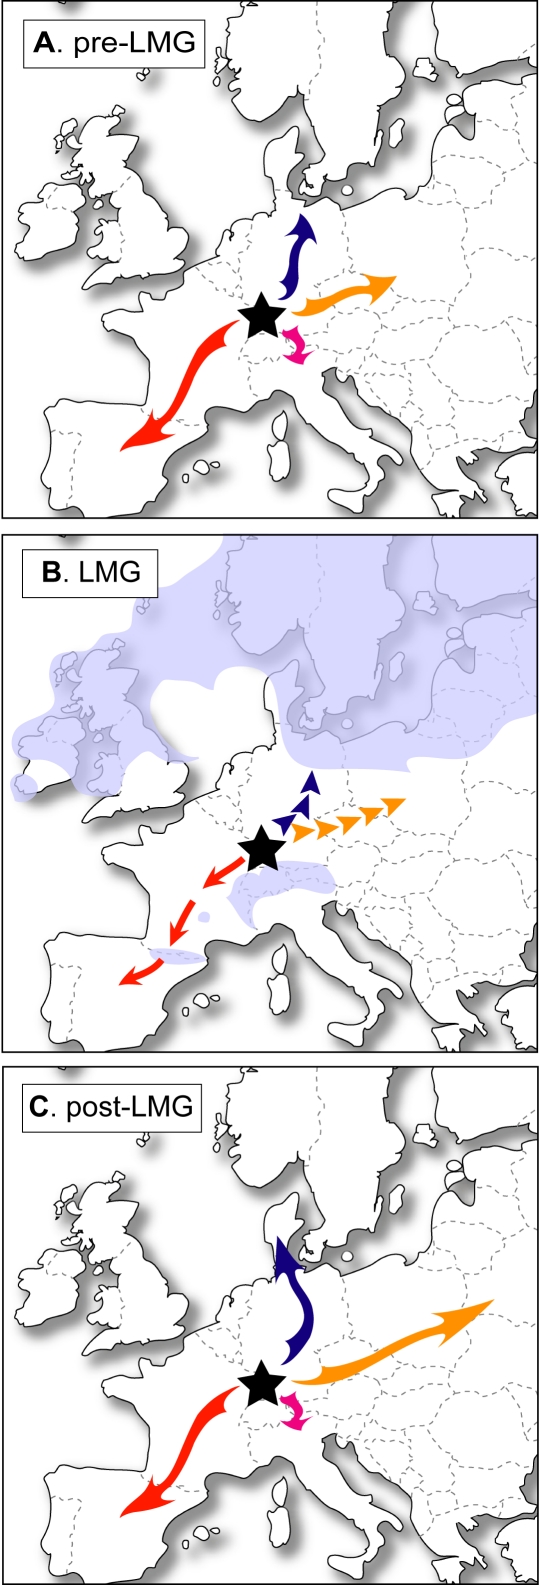
Estimated expansions of Microtus arvalis before (A), during (B) and after (C) the LGM.The black star locates the most likely origin of the species from fossil and genetic evidence. Solid arrows indicate the southwestward and northeastward gradual range expansion during warm periods, while dotted arrows are for more or less irregular expansion (Ù glacial survival in isolated populations or ä bottleneck events) during cold periods. Shaded areas (B) correspond to the estimated extension of ice cover.